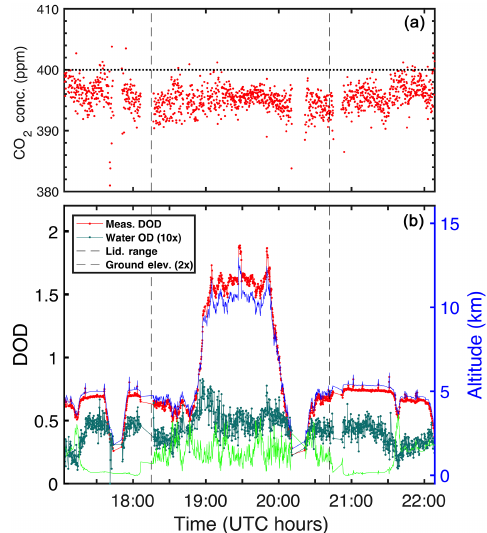
Figure 11. Lidar measurement and retrieval results from 2014 SF1 flight over the northern coast of CA on 20 August 2014. (a) The retrieved XCO 2 values from the lidar measurements, with each dot made using 10s averaging time. (b) Time-resolved results showing the lidar-measured differential optical depth in red, the range to the surface in blue and the computed elevation of the scattering surface in dark green. The upward spikes in the DOD and range are from the slant paths during the banking of the aircraft during the corners of the box pattern. The measurements between the dashed lines are summarized in Fig.